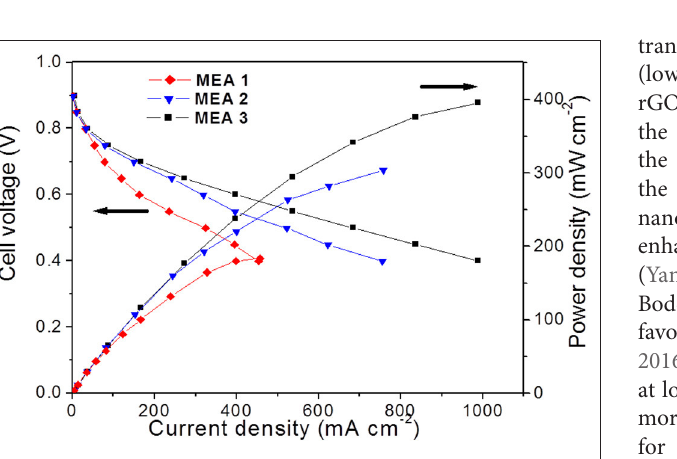
FIGURE 6 | Polarization (Left) and power density (Right) curves for the 3 designed MEAs. MEA1 contains single-layer electrodes without GDL, MEA2 contains single-layer electrodes with GDL and MEA3 contains double-layer